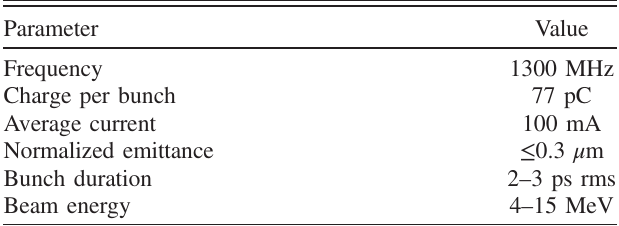
TABLE I. Requirements for the Cornell